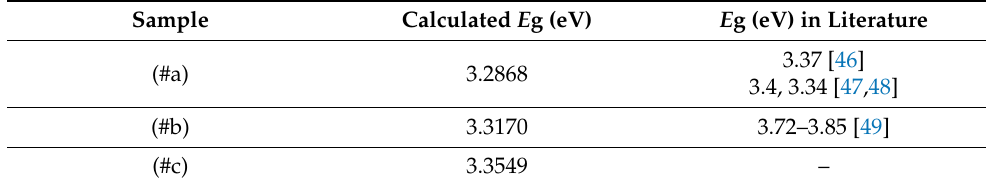
Table 4. Determination of E g band-gap values from the plot of ( α h ν ) vs. h ν and comparison to literature